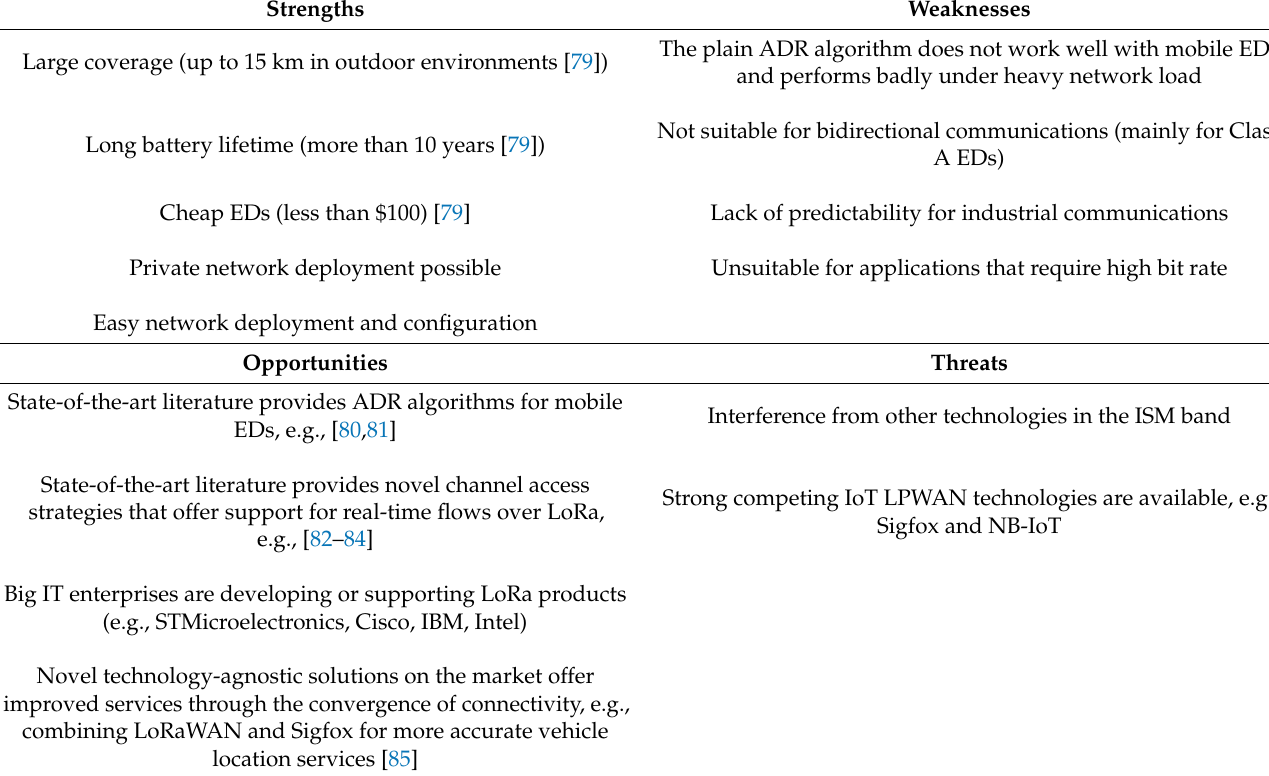
Table 2. SWOT analysis of